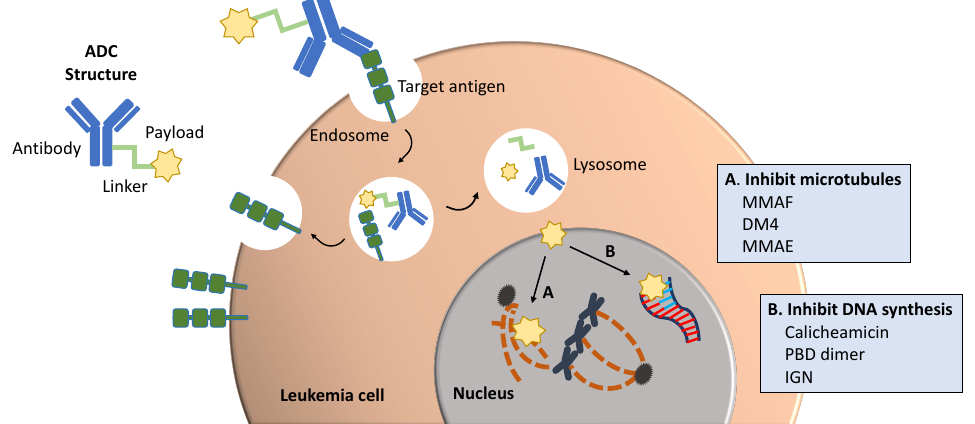
Figure 1. Antibody–drug conjugate structure and mechanisms of action. ADC structure demonstrated on the left consisting of a monoclonal antibody attached to a cytotoxic agent, or payload, by a chemical linker. The ADC binds to the target antigen on the leukemia cell surface, is internalized in an endosome, and then the linker is cleaved from the antibody and payload by chemical or enzymatic reaction in a lysosome. The payload inhibits ( A ) microtubule formation and function or ( B ) DNA synthesis leading to leukemia cell death. The target antigen is recycled back to the cell surface. MMAF, monomethyl auristatin F; DM4, ravtansine; MMAE, monomethyl auristatin E; PBD, pyrrolobenzodiazepine; IGN,